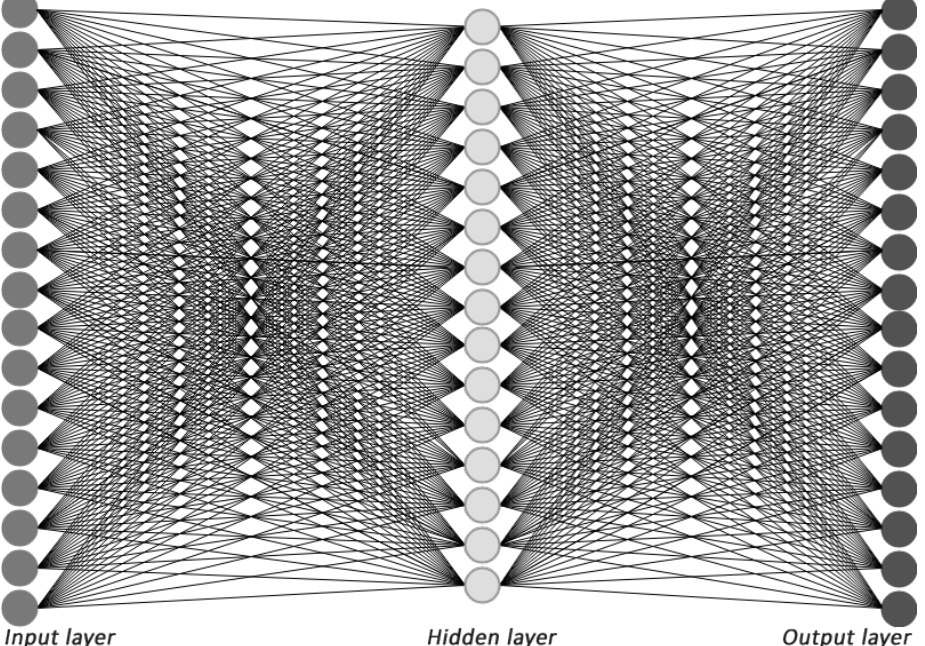
Figure 2. The configure of autoencoder with optimal number of neurons in hidden layer (15). The dimensionality is found using Grid Search over the neurons number from 2 to 15. For more details see Section